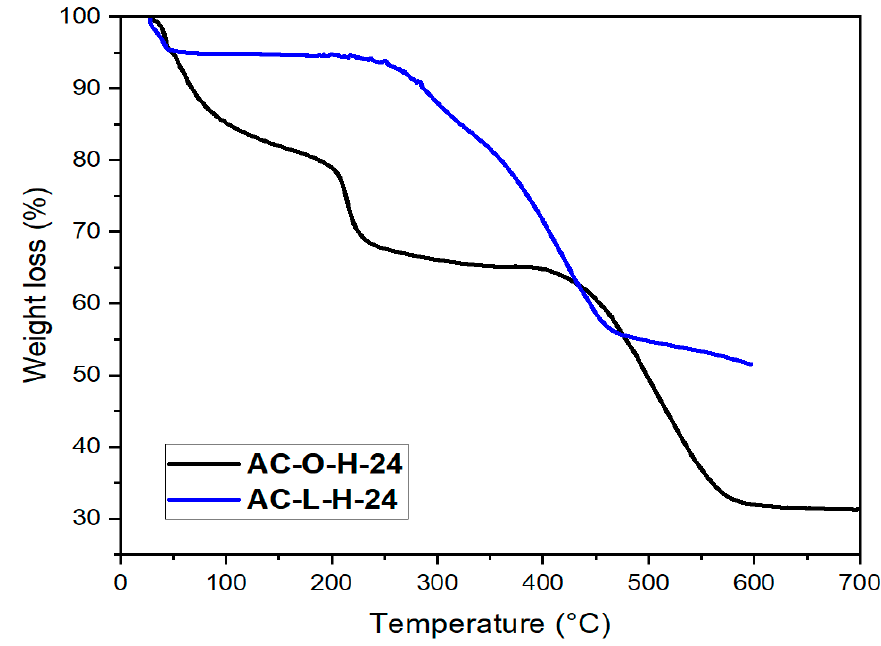
Figure 4. TGA analysis of activated carbon prepared from olive trees and Lantana camara .